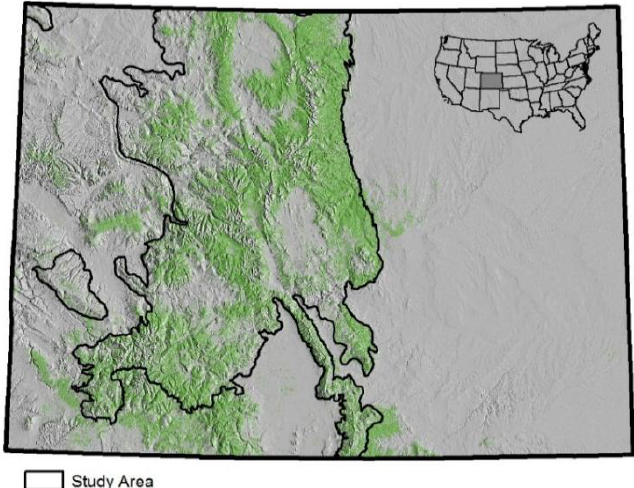
Figure 1. Study area (91,976 km 2 ) and spatial distribution of forest cover across the State of Colorado, which covers an area 600 km east to west and 450 km north to south.